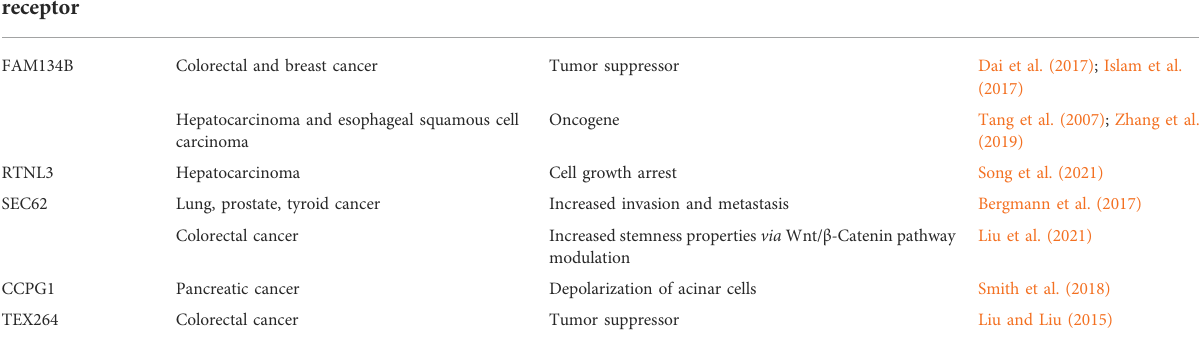
TABLE 1 ER-phagy receptors in different cancer